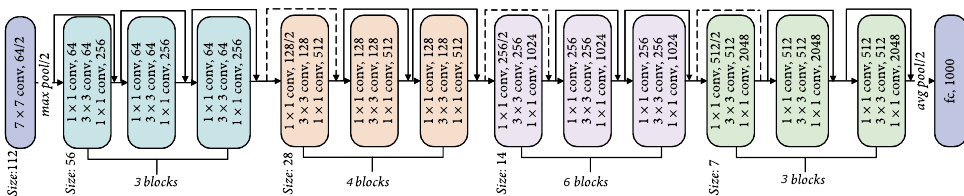
Figure 8. The architecture of the ResNet-50 model [21], used as backbone for our Faster R-CNN based anomaly detection method. Image adapted from